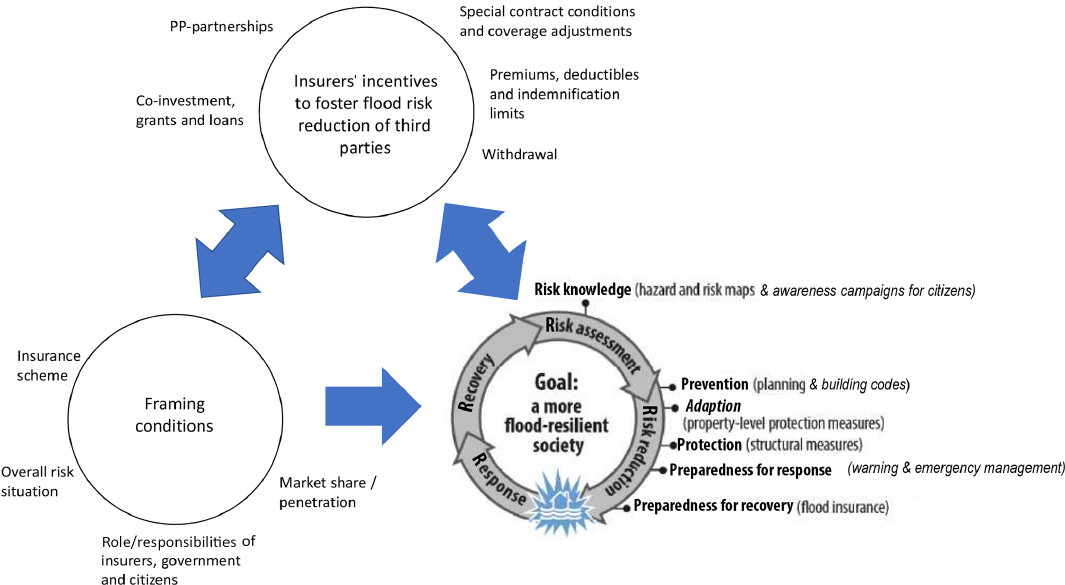
Figure 2. Assessment framework for interdependencies between insurance schemes, flood risk reduction measures, and insurers’ incentives for flood risk reduction; the flood risk management cycle (lower right corner) was adapted from Surminski and Thieken